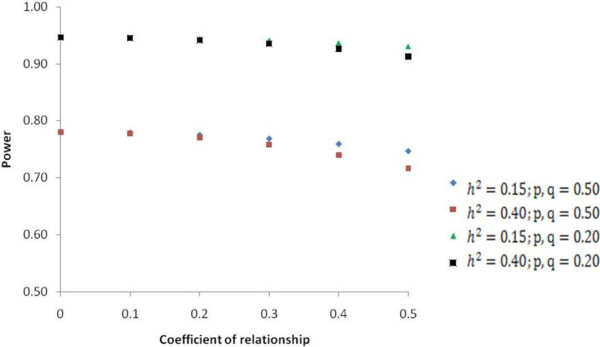
Power of detecting marker-trait association for various parameters: sample size =1,120; Linkage disequilibrium (r2) = 0.25; QTL size = 2% of phenotypic variation; Marker (p) and QTL (q) allele frequency = 0.50 or 0.20; Narrow-sense heritability (h2) = 0.15 and 0.40.